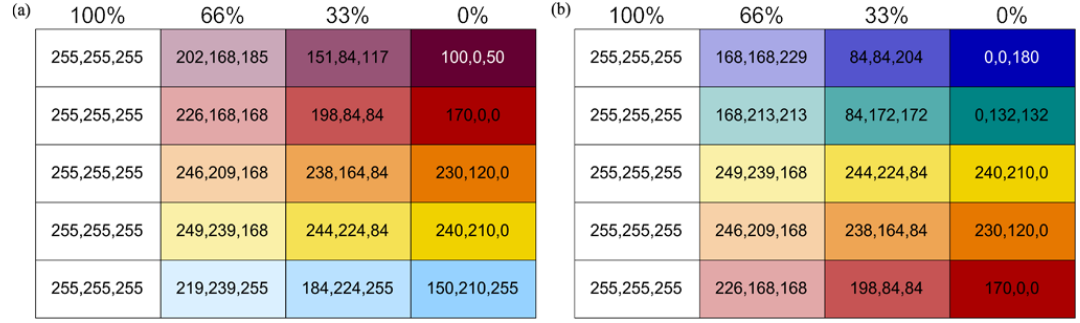
Fig. 8. (a) Alternative to the desaturated legend in Fig. 7a, suitable for showing temperature anomalies and associated uncertainty. (b) Alter- native to the desaturated legend in Fig. 7b, suitable for showing precipitation anomalies and associated uncertainty.